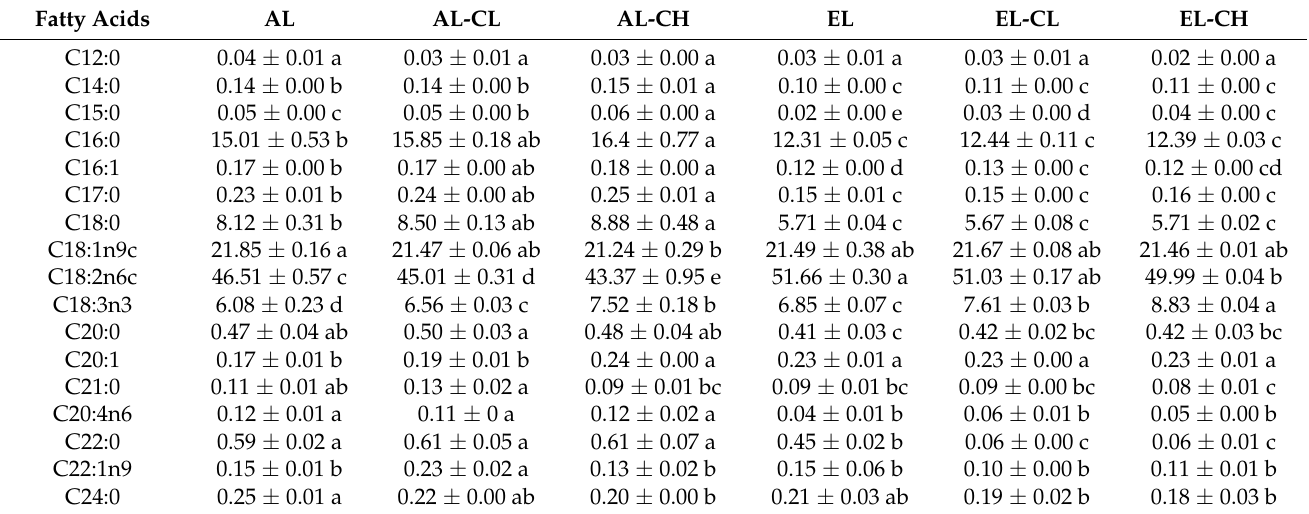
Table 2. Fatty acid composition (%) after in vitro simulated gastrointestinal